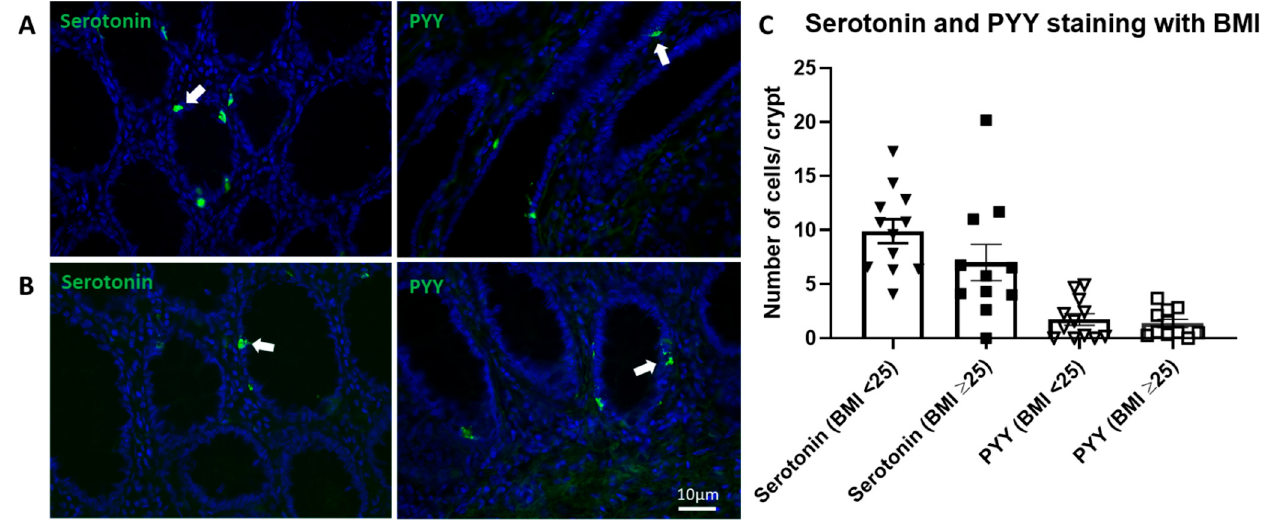
Figure 2. Serotonin and PYY immunohistochemistry expression in human colonic tissue of BMI < 25 and ≥ 25. ( A , B ): Rep- resentative images of serotonin and PYY expression in patients of BMI < 25 and BMI ≥ 25, respectively. Arrows denote serotonin and PYY positive cells. ( C ): Counts of cells per crypt stained positively for serotonin and PYY, grouped as BMI < 25 ( n = 12) and BMI ≥ 25 ( n = 11). Scale bars represent 10 μ m.